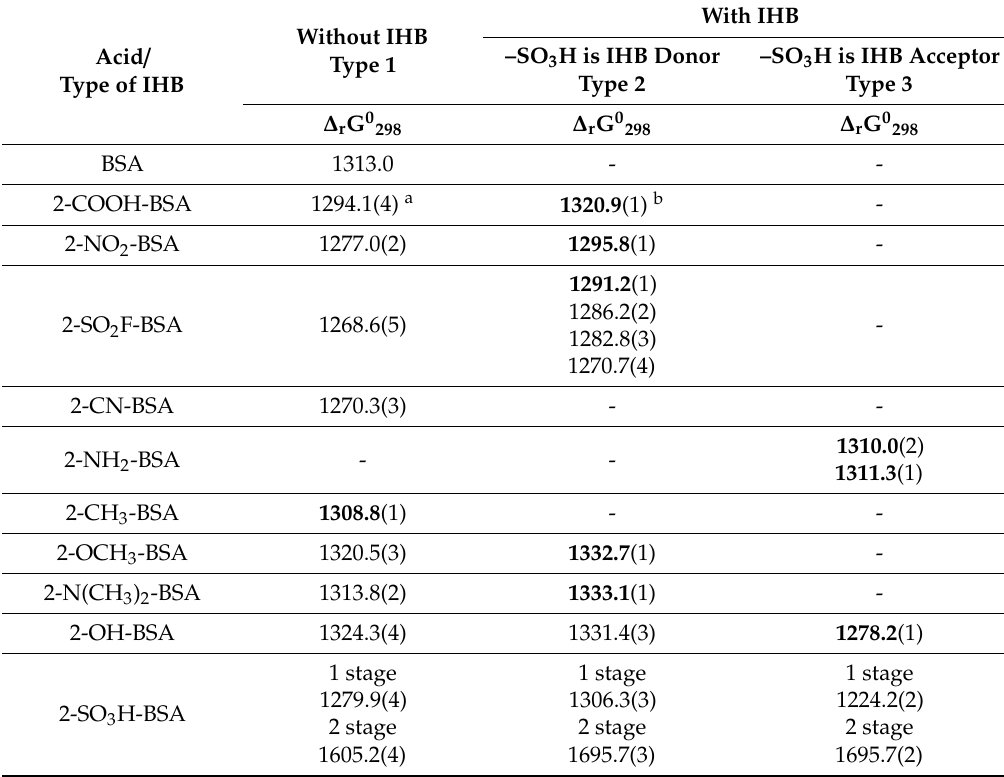
Table 4. Gibbs free energies of GD kJ mol − 1 ) for conformers of ortho -substituted BSA with a di ff erent type of IHB (conformer numbers in